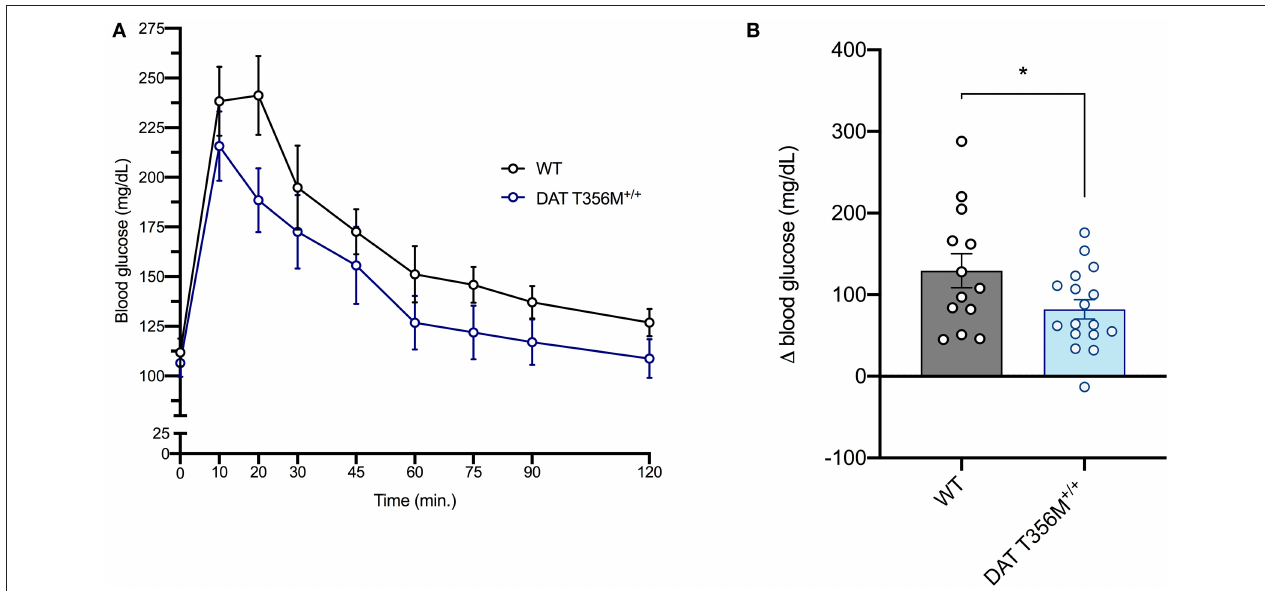
FIGURE 2 | DAT T356M + / + mice have improved glucose handling after glucose challenge. (A) Blood glucose levels during a glucose tolerance test in WT and DAT T356M + / + mice. (B) Change in blood glucose from baseline to 20min ( 1 blood glucose) is significantly reduced in DAT T356M + / + mice compared to WT mice (WT = 129.4 ± 20.80 mg/dL, DAT T356M + / + = 81.94 ± 11.78 mg/dL; n = 13 WT, 17 DAT T356M + / + ; t = 2.100, df = 28, * = p = 0.0448 by Student’s t